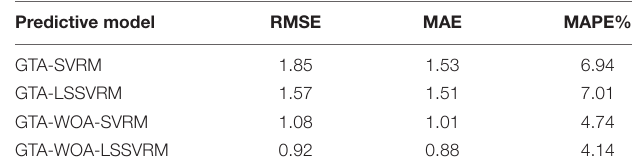
TABLE 4 | Prediction accuracies of various